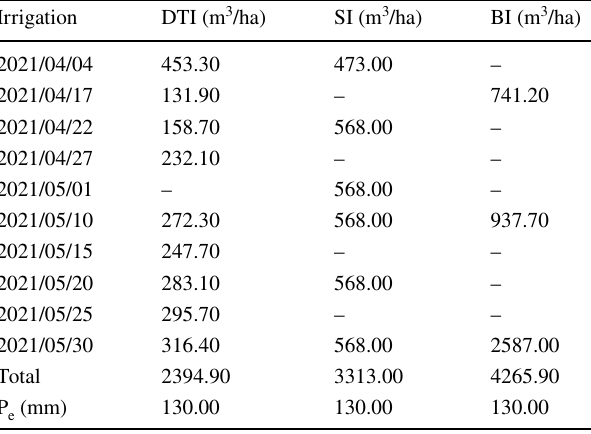
Table 3 Applied water and effective rainfall in different treatments